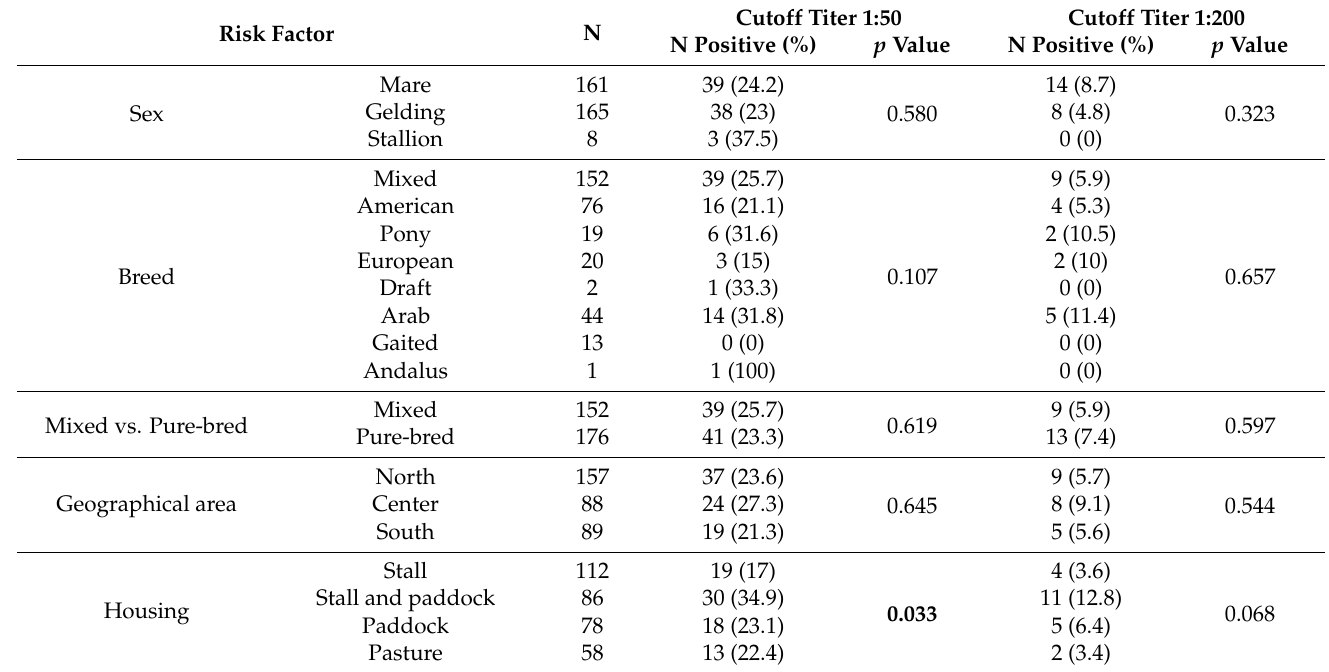
Table 1. Neospora spp. seroprevalence in the first study population of apparently healthy horses, according to the different risk factors (sex, breed, geographical location, and housing management).